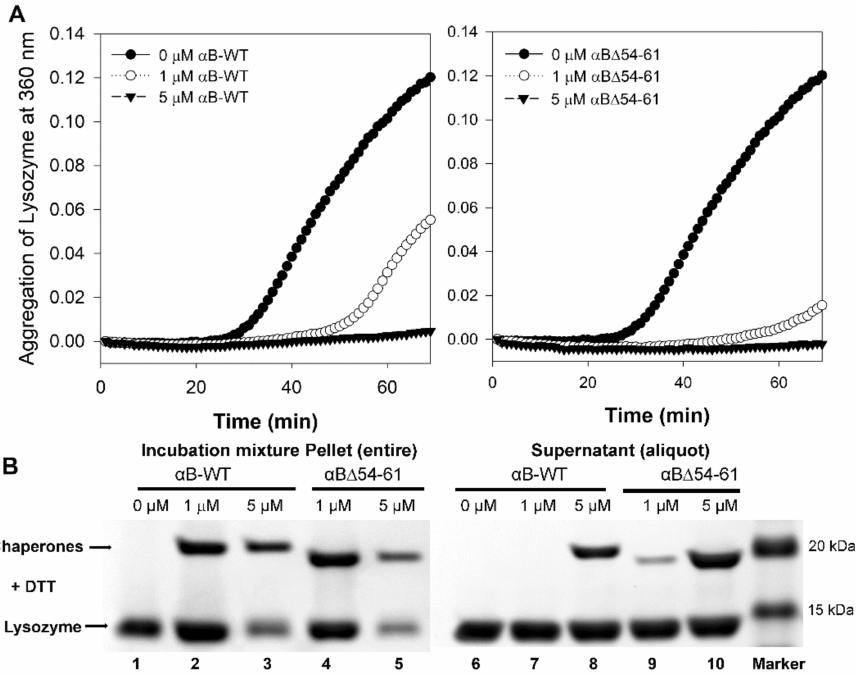
Figure 5. ( A ) Comparison of chaperone activity of α B-wt and α B ∆ 54–61 at two equimolar concen- trations (1 and 5 µ M) using lysozyme (5 µ M) as the aggregation substrate. ( B ) SDS-PAGE of the chaperone assay supernatant and pellet fractions analyzed at the end of the assay. The α B ∆ 54–61 has a higher substrate binding capacity than that of α